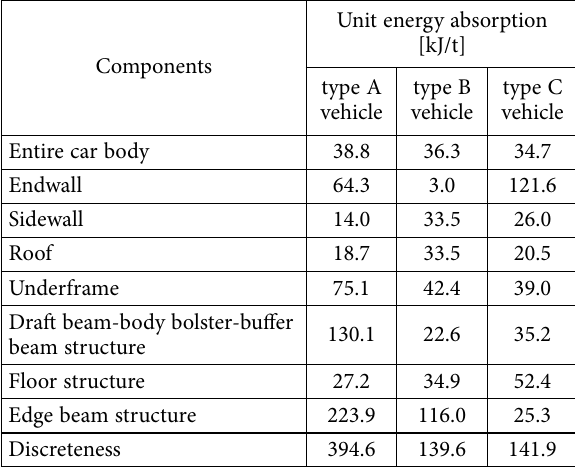
Table 3. Energy absorption parameters for three types of